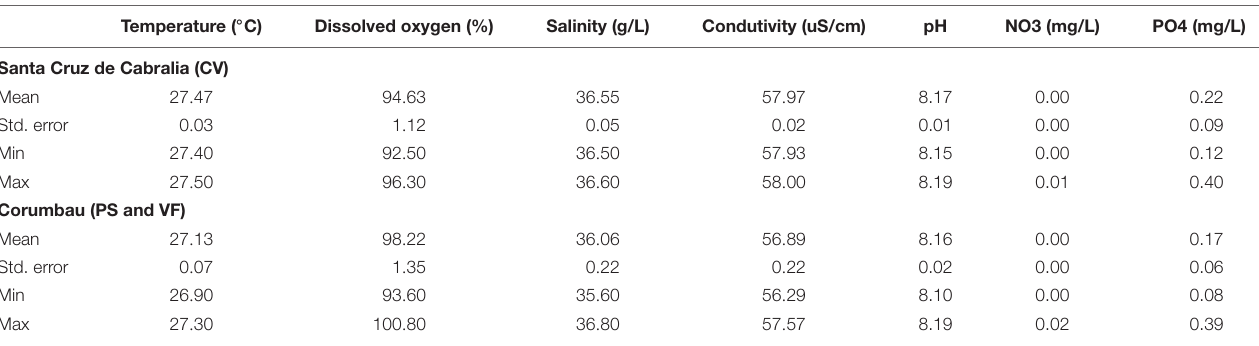
FIGURE 2 | Sea surface temperatures (SST) and degree heating weeks (DHW) in the last decade using daily temperature readings from the Abrolhos reef. The bleaching threshold for the region is 27.9 ◦ C. The year 2019 contained the highest recorded SST and DHW values of the last decade. TABLE 1 | Summary statistics of physical-chemical parameters from Santa Cruz de Cabralia and